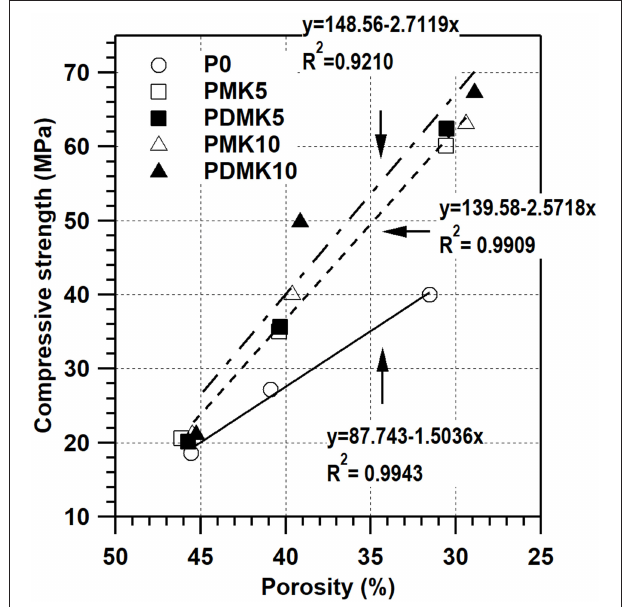
FIGURE 6 | Relationship between the compressive strength and porosity of cement paste, pastes with powder MK, and pre-dispersed MK. Specimens with a porosity of ∼ 45% were cured for 3 days, those with a porosity of 35–42% were cured for 7 days and those with a porosity of 25–35% were cured for 28 days.